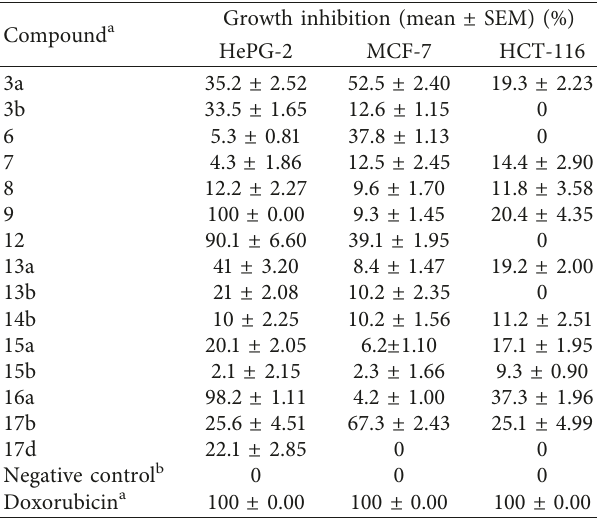
Table 1: Cytotoxic activity of the newly synthesized compounds against human carcinoma cell lines at 100 μ M.